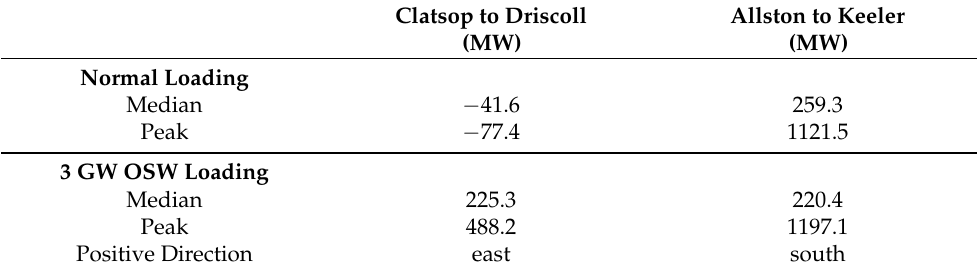
Figure 9. Transmission map for Northern Oregon [28]. OSW interconnection point, Clatsop substation highlighted in yellow. Table 5. Coastal transmission loading for Northern Oregon.